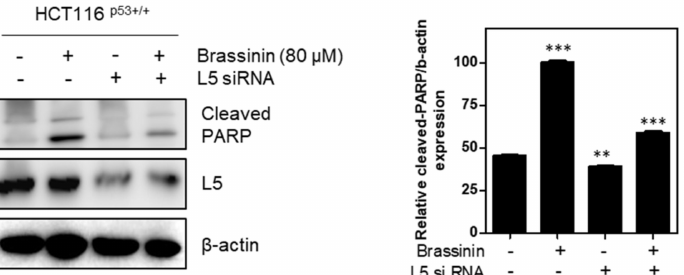
Figure 3. Brassinin induces apoptosis through the L5. HCT116 p53+/+ cells were transfected with L5 siRNA (40 nM) or scramble siRNA for 48 h. After that, cells were treated with Brassinin (80 µ M) for 24 h. Cleaved-PARP and L5 were determined by western blotting. ** p < 0.01, *** p < 0.001 vs. untreated control. Values of Western blotting images represent relative level of protein expression/ β -actin.